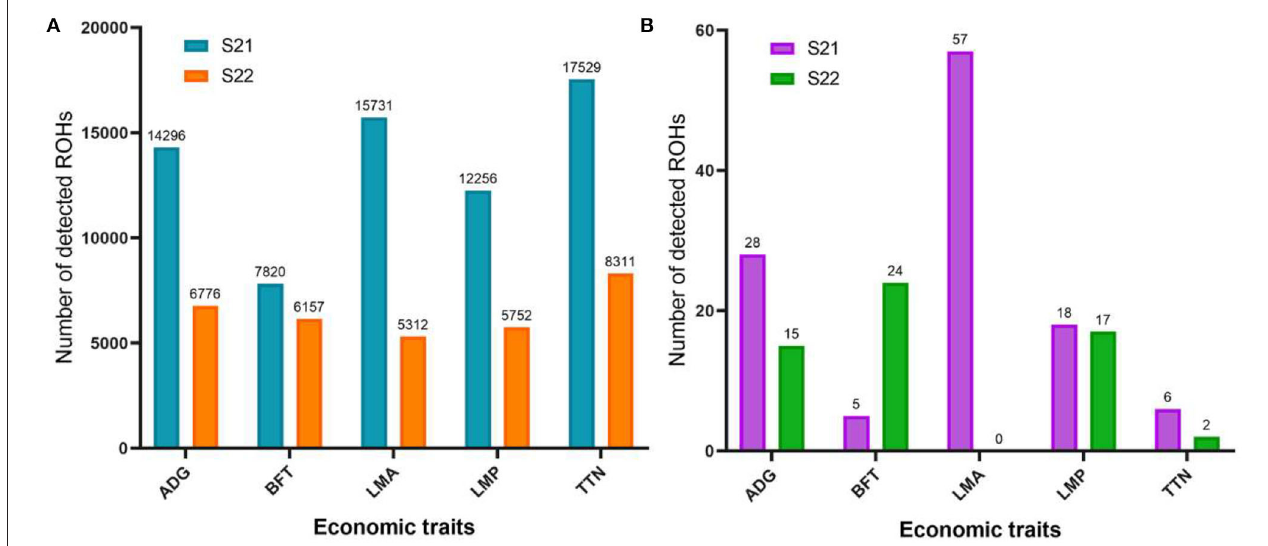
FIGURE 1 | Number of unfavorable ROHs detected in two Duroc populations. (A) Total number of detected unfavorable ROHs. (B) Number of significantly unfavorable ROHs based on FDR = 0.1 and at least 50 SNPs. S21, Duroc pigs of American origin; S22, Duroc pigs of Canadian origin; ADG, average daily gain at